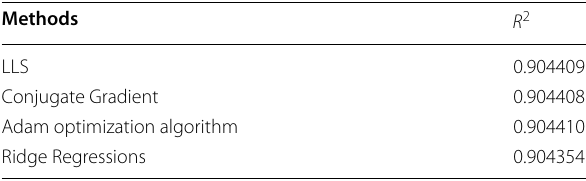
Table 6 R 2 Score for different methods